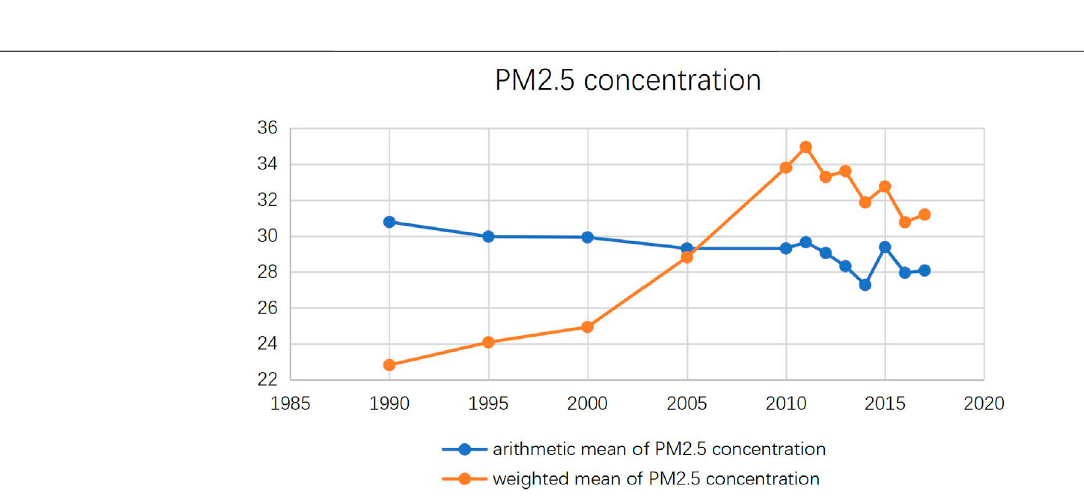
FIGURE 1 | Trend line of mean value of dynamic TFP and its decomposition index.